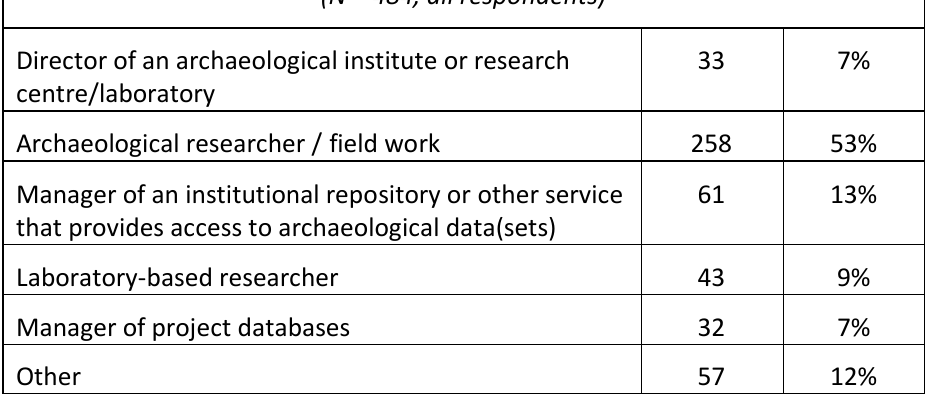
Table 5 : Which of the following describes best your main professional activity? (N = 484, all